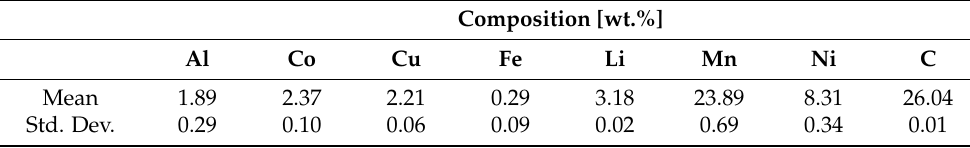
Table 2. Composition of LIB black mass in wt.% analyzed by ICP-OES, AAS, and combustion. Composition